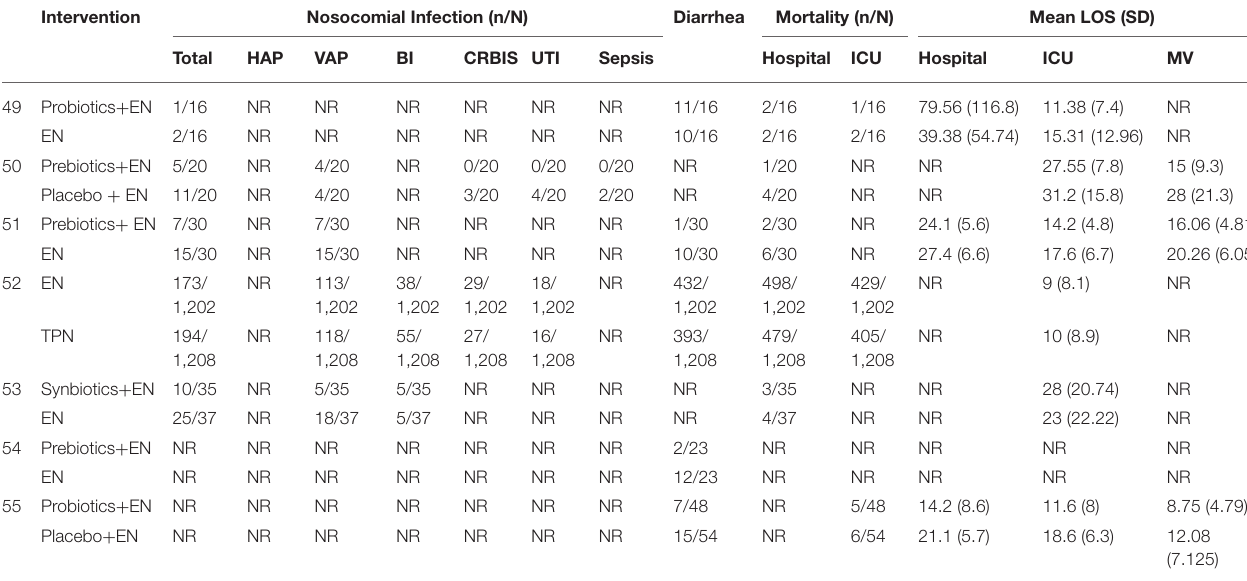
patients and patients with initial time of nutrition therapy beyond 48 h, while TPN was shown to increase the morbidity of NI in different disease subgroups except MV patients (OR 1.31